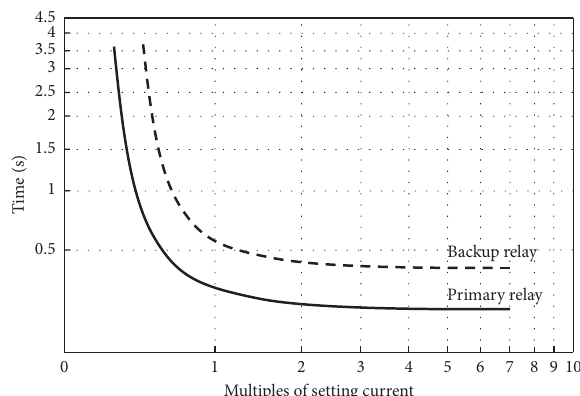
Figure 1: The conventional time-current curve and coordination of DOCRs.